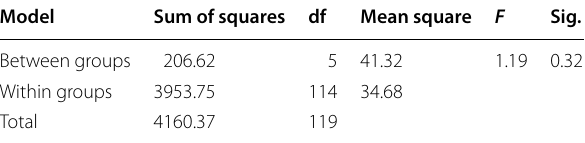
Table 7 Variance analysis results of door width